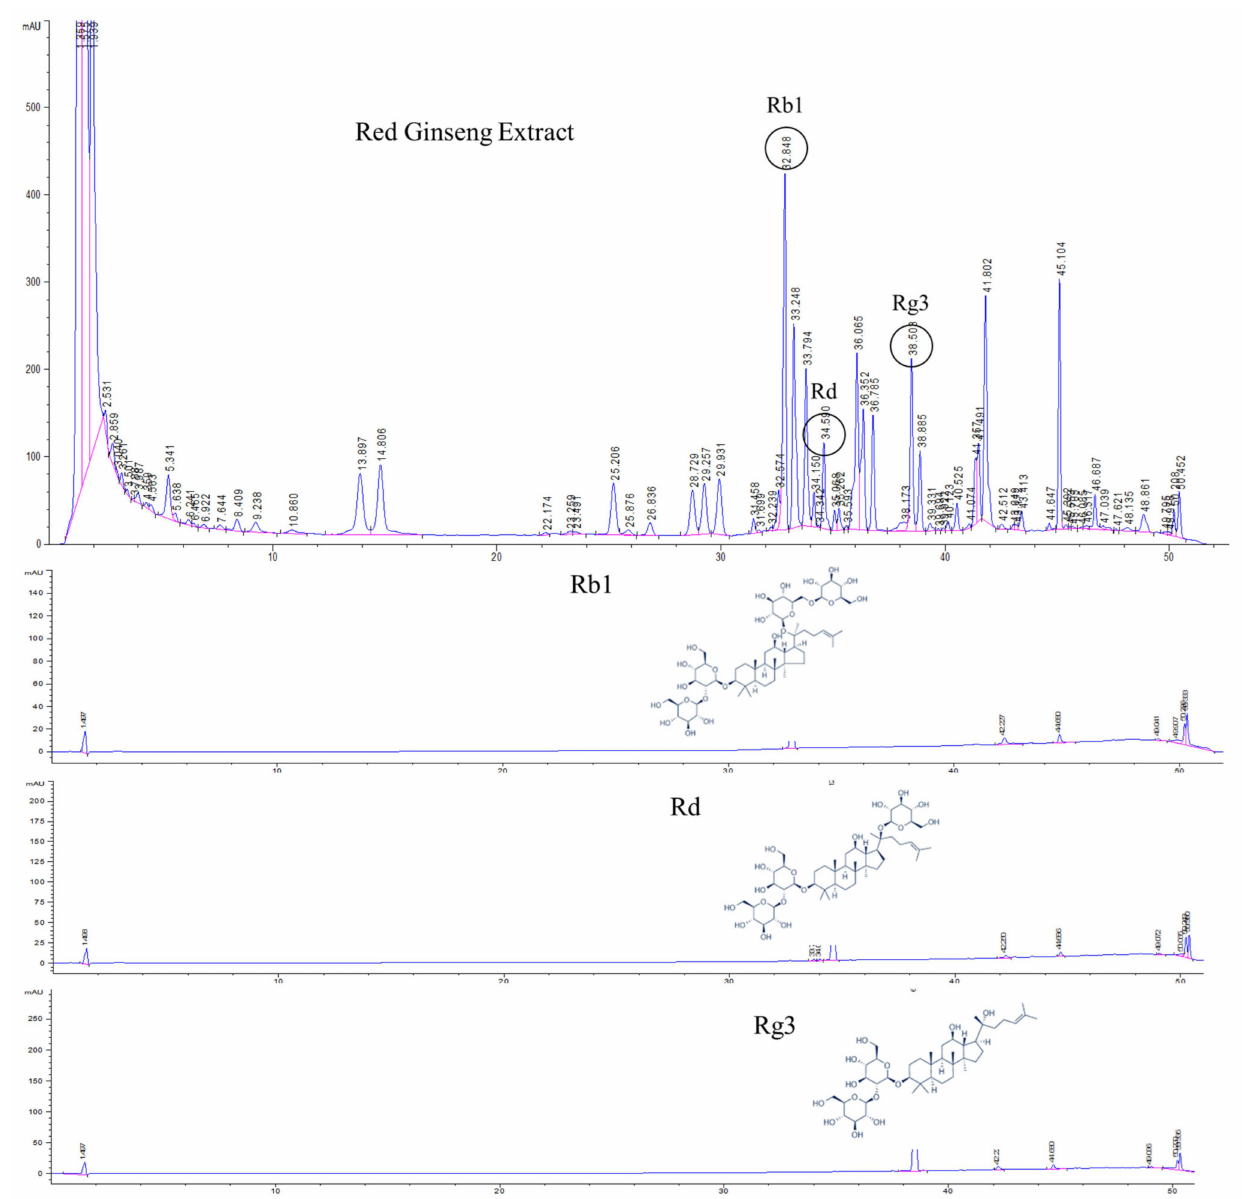
Figure 1. High-performance liquid chromatography (HPLC) analysis of Korean red ginseng (KRG) was carried out with an ultraviolet (UV) detector for quantitative analysis of the major ginseno- sides. The 20( S )-protopanaxadiol ginsenoside Rb1, 20( S )-protopanaxadiol ginsenoside Rd, and 20( S )-protopanaxatriol ginsenoside Rg3 were